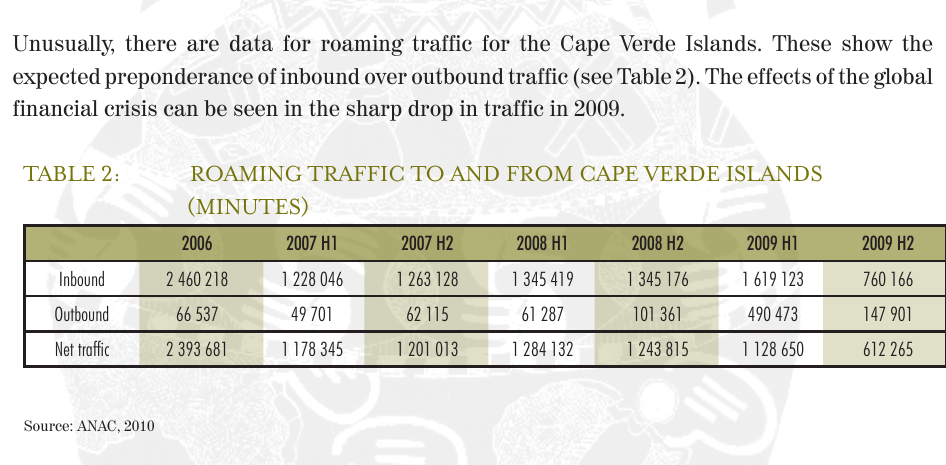
ROAMING TRAFFIC TO AND FROM CAPE VERDE ISLANDS